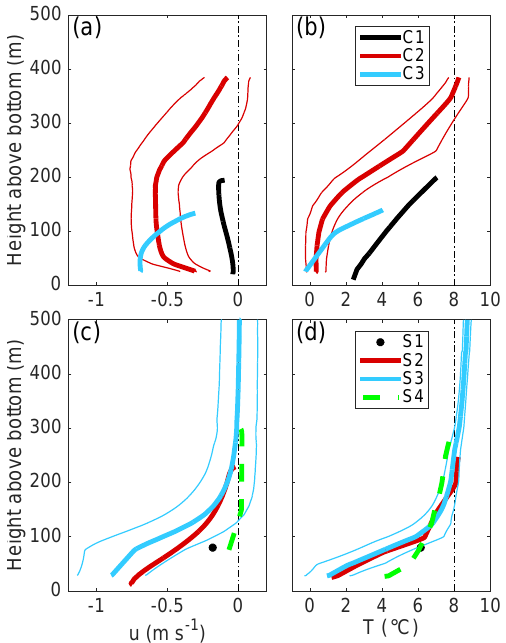
Figure 3. Mean vertical profiles of along-stream velocity u (left; a , c ) and temperature (right; b , d ) from the moorings in the C array (top; a , b ) and the S array (bottom; c , d ). Time-average profiles over the whole deployment are shown as bold lines, and 1 standard deviation from the mean as thin lines, shown for one mooring in each array (C2, S3). Thin black dash-dotted lines mark 0ms − 1 and 8 ◦ C, respectively. Only levels from which data are available at least 70% of the time are included.